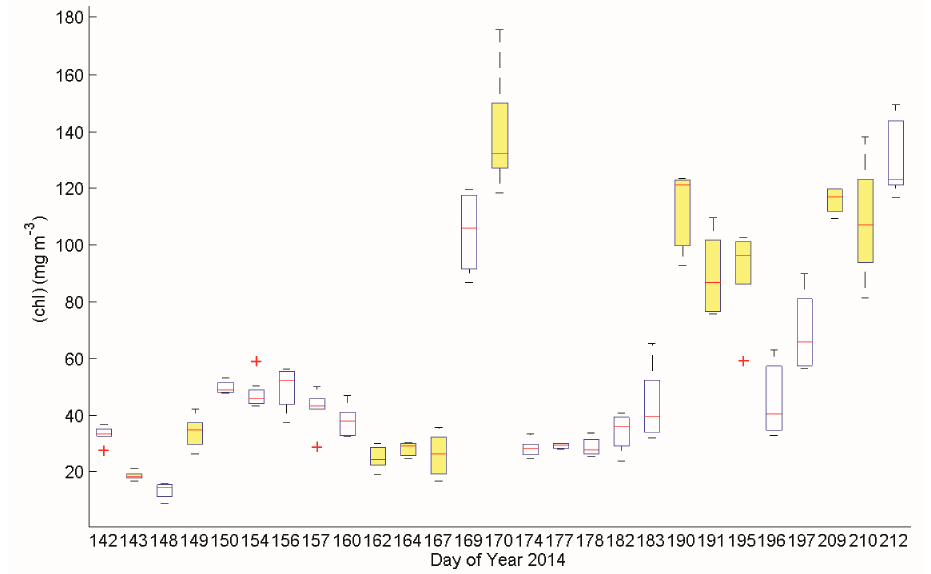
Figure 5. Boxplots of measured chlorophyll concentrations ((chl)) for samples collected in the Wabash River during the summer of 2014. Boxes filled with yellow color indicate that there is a statistically significant different ( p < 0.05) between observations on the highlighted day and the previous day.